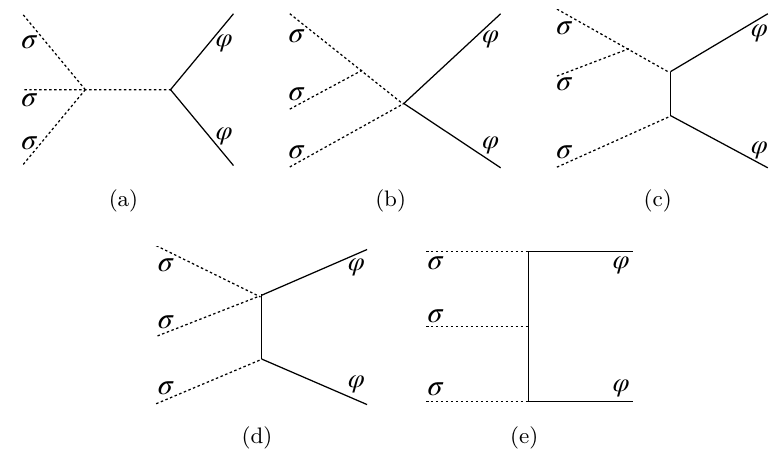
Figure 3 . The leading order Feynman diagrams of σσσϕϕ scattering.